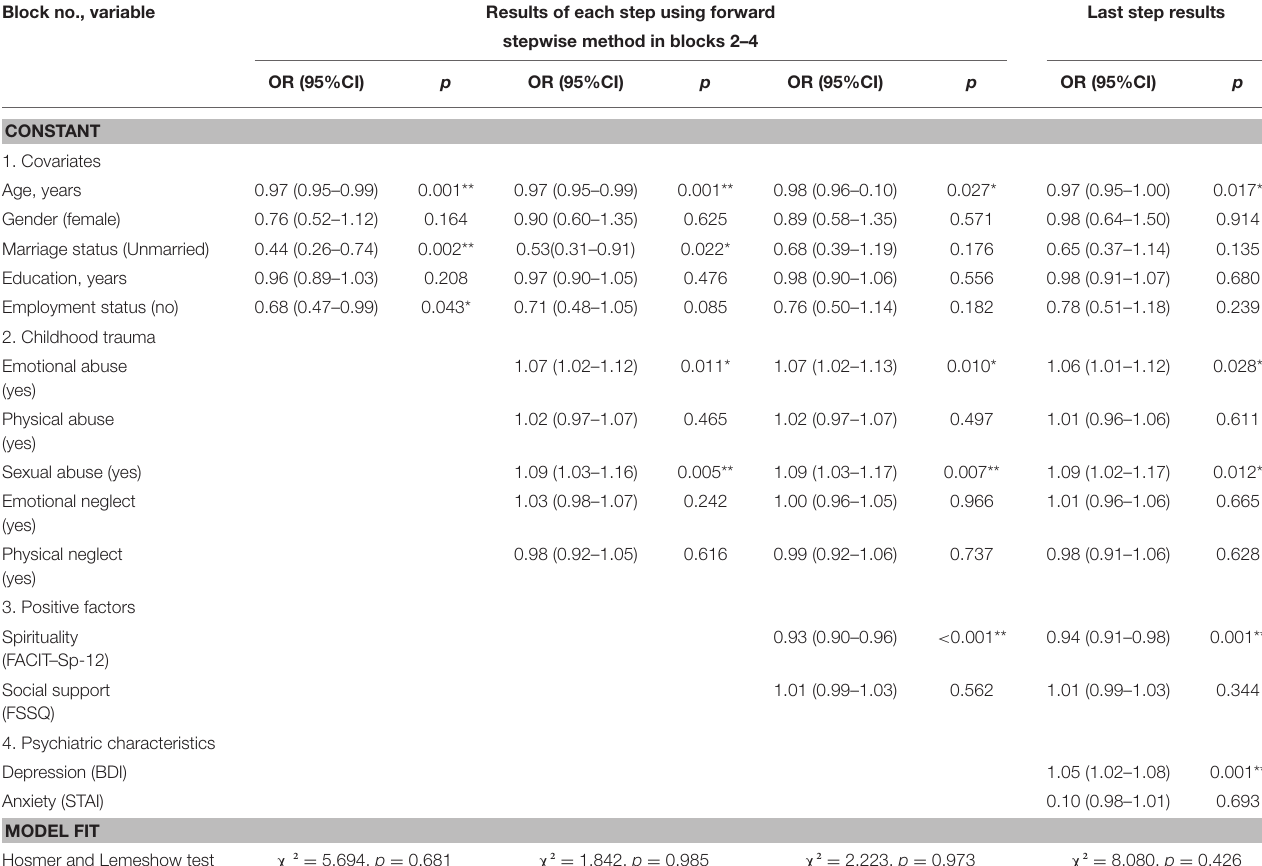
TABLE 2 | Results of hierarchical logistic regression model to identify factors related to suicide attempts. Block no.,